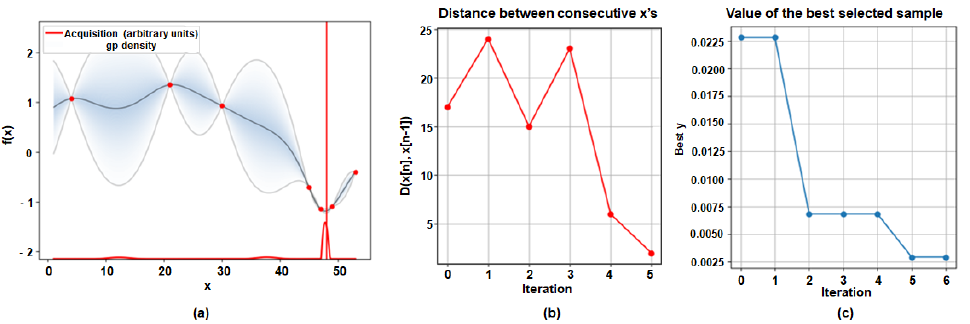
Figure 5. Visualization results of the optimal sharing layer configuration through BayesOpt as threshold accuracy degradation is 2% less than the baseline accuracy. (70 classes/30 classes) ( a ) the result of the selected optimal number of sharing layers. ( b ) The L2 distance of the consecutive observed points. ( c ) The value of the calculated best-selected sample for every iteration.